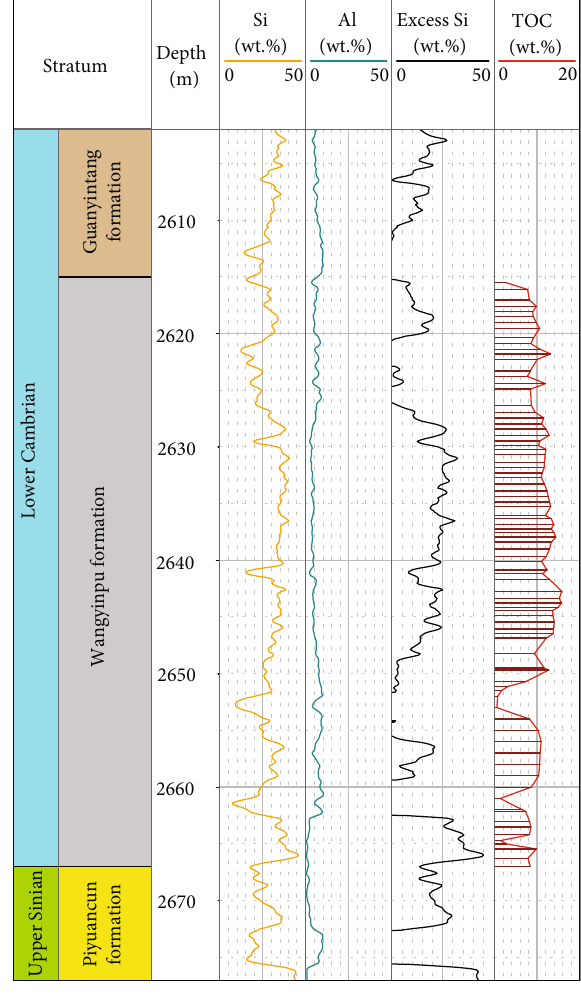
Figure 4: Excess silicon and TOC content of the Lower Cambrian Wangyinpu Formation in the Yangtze area from Well JXY1. See Figure 1 for the well